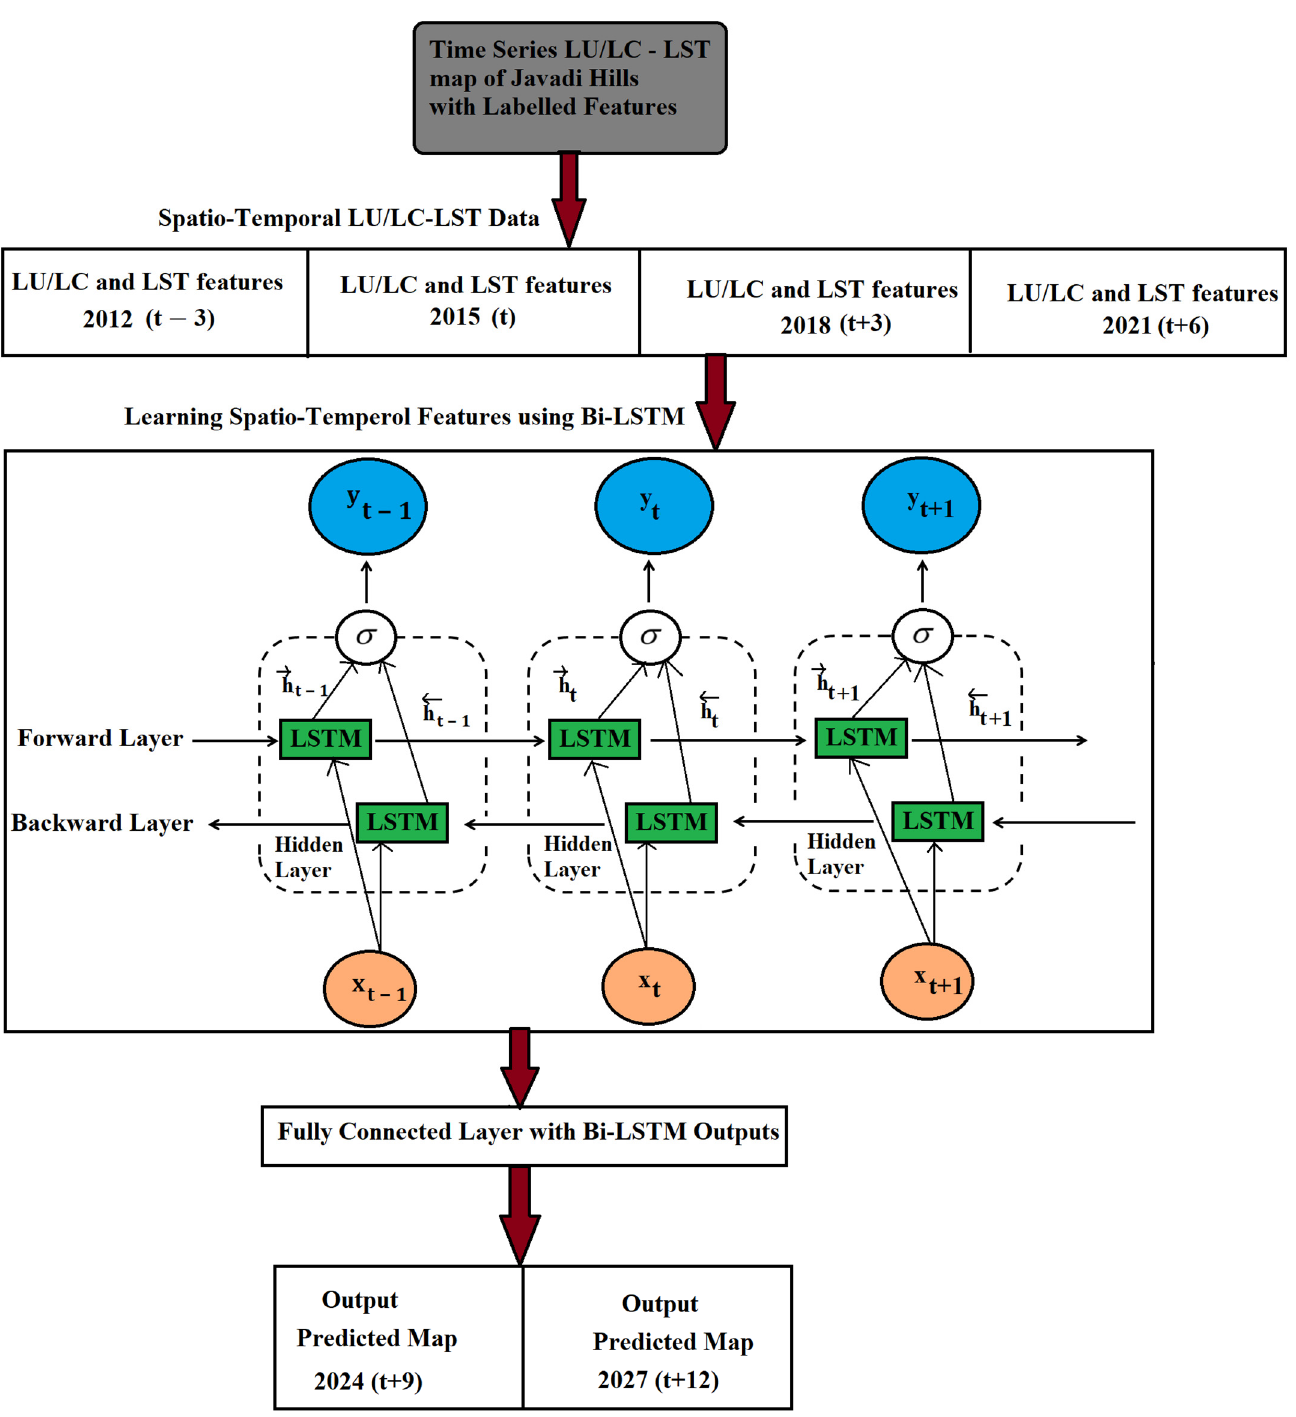
Figure 12. Bi-LSTM model for LU/LC